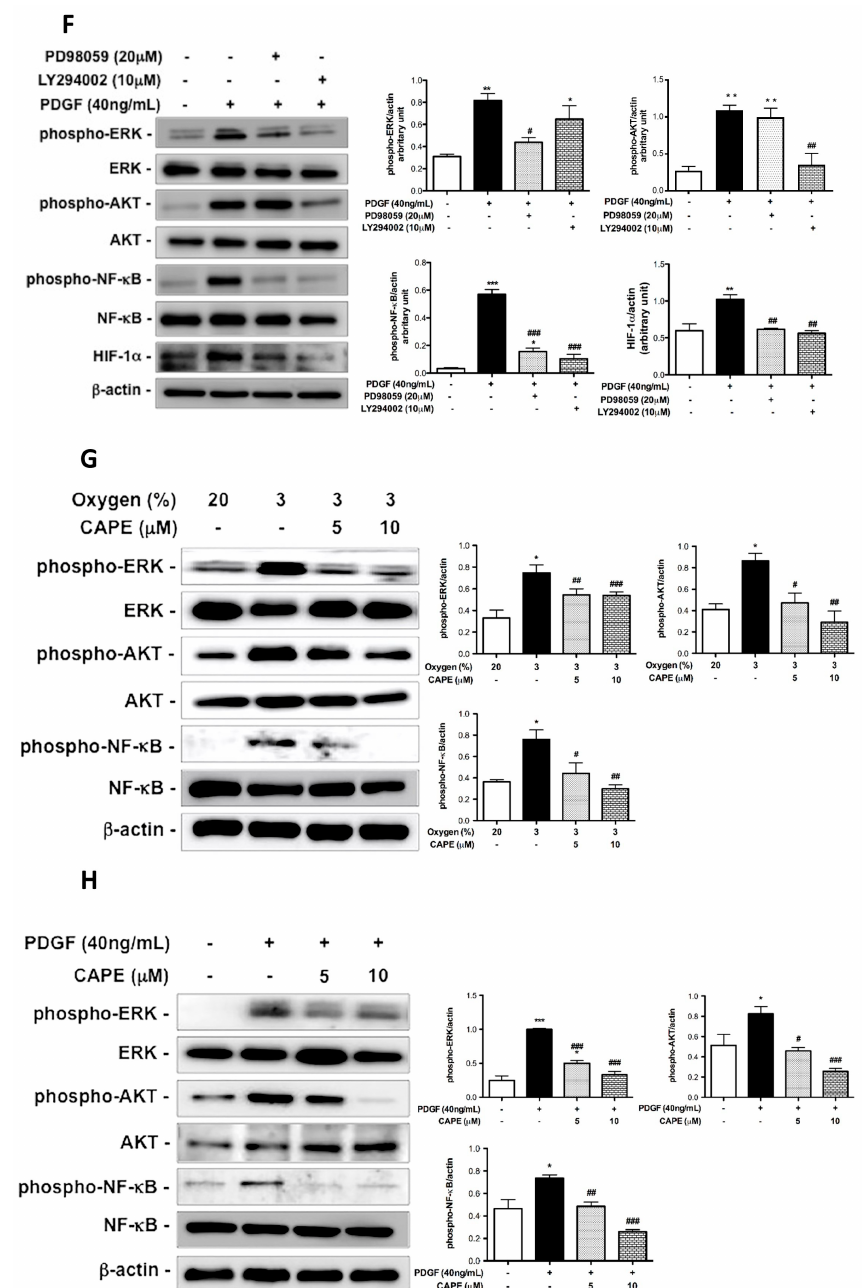
Figure 4. CAPE inhibits hypoxia- and PDGF-BB-induced HIF-1 α expression through a AKT/ERK pathway in human PASMCs. ( A ) Cells were cultured for 24 h in normoxia (20%) or hypoxia (3%) with or without CAPE (5 or 10 μ M). ( B ) Cells were pretreated with CAPE for 2 h, and then treated with or without PDGF-BB for 24 h. The HIF-1 α mRNA levels were determined by real-time PCR. ( C ) Cells were cultured for 6 h in normoxia (20%) or hypoxia (3%) with or without CAPE (5 or 10 μ M). ( D ) Cells were pretreated with CAPE for 2 h, and then treated with or without PDGF-BB for 6 h. The HIF-1 α expression was determined by Western blot. ( E – H ) Production of phospho-ERK, AKT, NF- κ B and expression of HIF-1 α by human PASMCs. Cells were pretreated in the absence of inhibitor or with PD98059 (20 µ M), LY294002 (10 µ M), or CAPE (5 or 10 µ M) for 2h, and then were cultured for 4 h in normoxia (20%), hypoxia (3%), or PDGF-BB. Cell lysates were examined by Western blotting using specific antibodies. Values are the mean ± SEM of three independent experiments. * p < 0.05; ** p < 0.002; *** p < 0.001, as compared with the control group. # p < 0.05; ## p < 0.002; ### p < 0.001, as compared with the cells exposed to hypoxia or